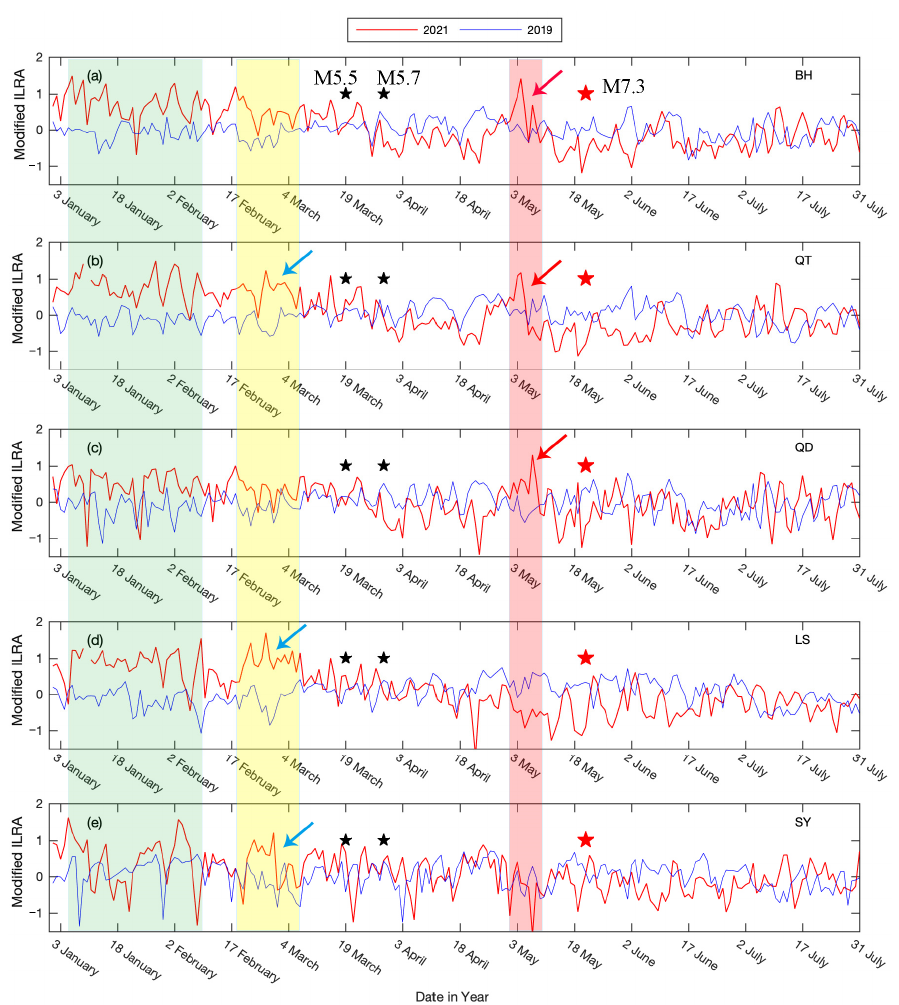
Figure 10. Time series of ILRA variations in different tectonic blocks in 2019 and 2021: ( a ) Bayan Har block—BH; ( b ) Qiangtang block—QT; ( c ) Qaidam block—QD; ( d ) Lhasa block—LS; and ( e ) Sichuan–Yunnan block—SY. The red star represents the Madoi M 7.3 earthquake, and black stars indicate two moderate earthquakes that occurred in the Qiangtang tectonic block.